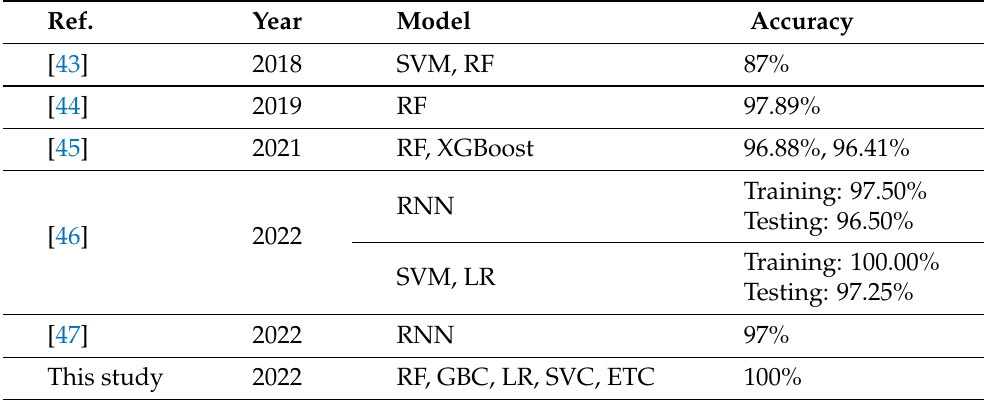
Table 19. Performance of the proposed approach on the Feeling Emotions dataset.